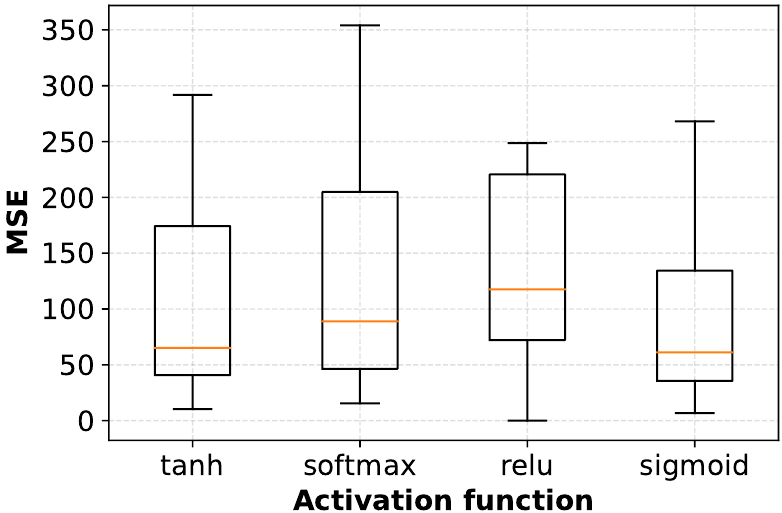
Figure 13. MSE performance distribution of the 3-layer ANN model with different activation functions (i.e., tanh, softmax, ReLU, sigmoid).